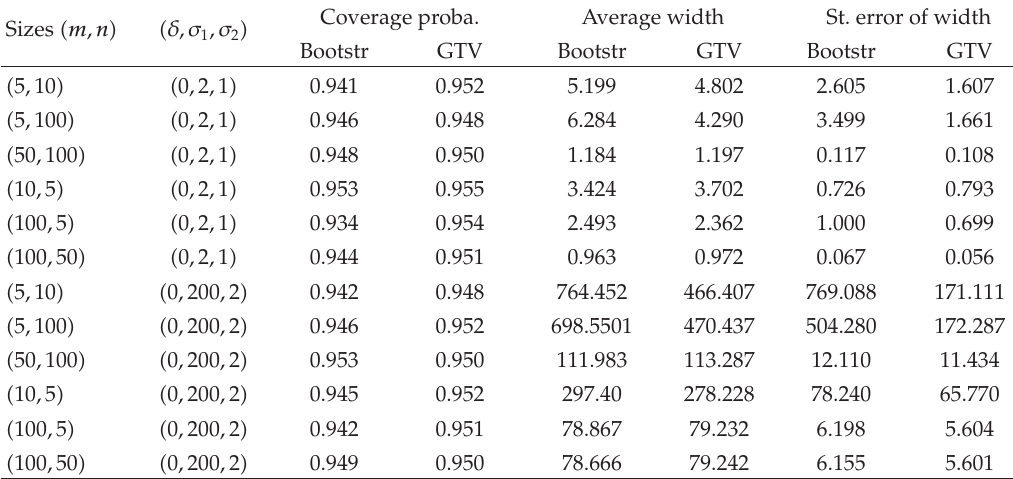
Table 6: Comparison with the bootstrap method (cid:2) normal case with unequal sample sizes (cid:3)